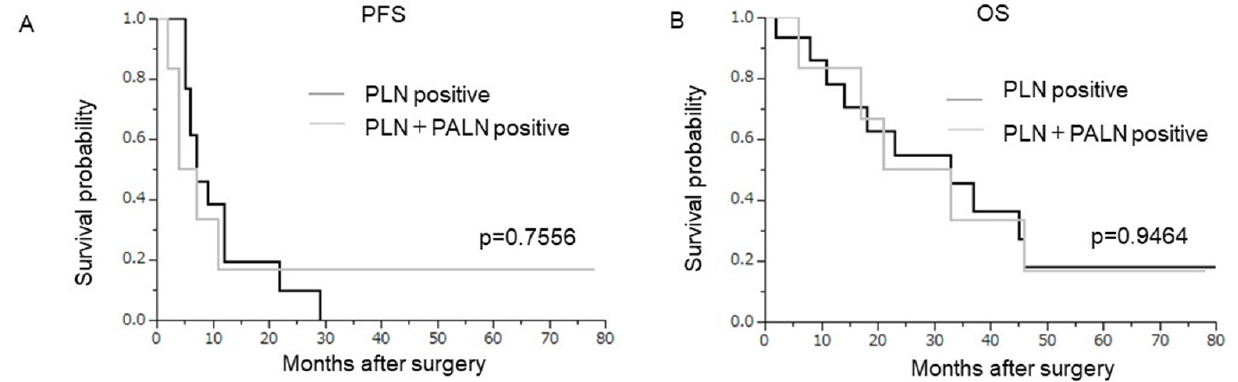
Figure 3. Prognostic significance of the location of lymph node metastases in node-positive patients. Kaplan–Meier estimates of survival according to the location of lymph nodes (PLN ( n = 15) versus PLN+PALN ( n = 6)). ( A ) Progression-free survival (PLN versus PLN+PALN, p = 0.7556). ( B ) Overall survival (PLN versus PLN+PALN, p = 0.9464).